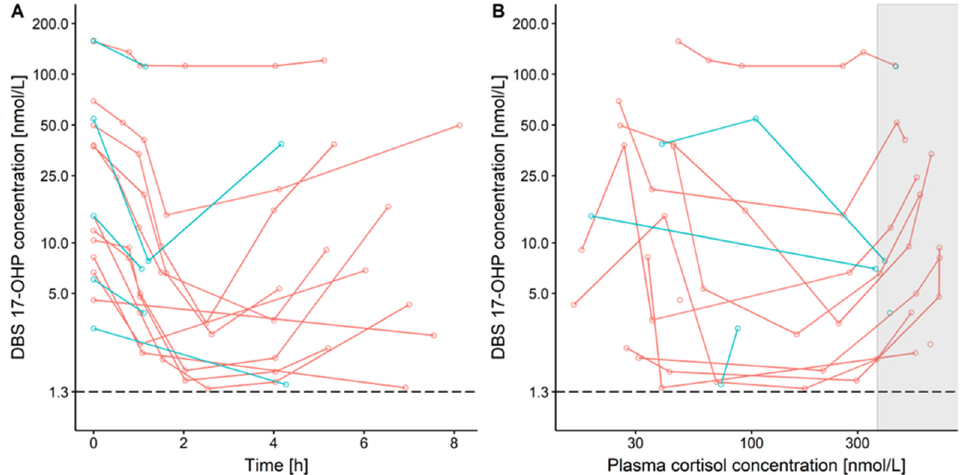
Figure 3. 17 α -hydroxyprogesterone (17-OHP) concentrations measured in venous dried blood spots (DBS) over time after first (baseline) observation, semi-log scale ( A ) and versus plasma cortisol concentration, log scales ( B ), in pediatric CAH patients receiving hydrocortisone single morning dose. Red: young children, blue: infants, dashed line: lower limit of quantification = 1.3 nmol/L, gray box: highest plasma cortisol concentrations directly after hydrocortisone administration.